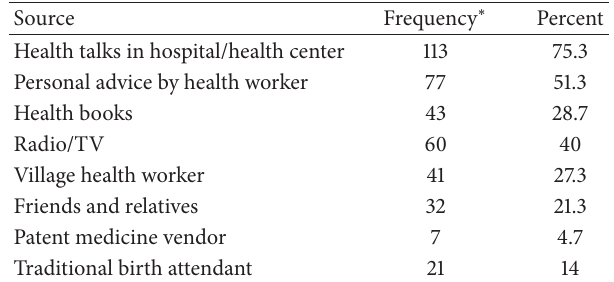
Table 3: Source of information.